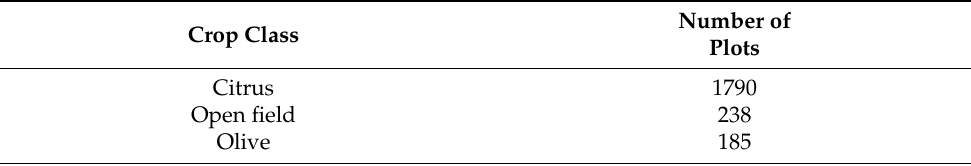
Figure 3. Distribution of ground truth data acquired in the Cape Bon region. Table 1. Number of plots of ground truth land used for crop